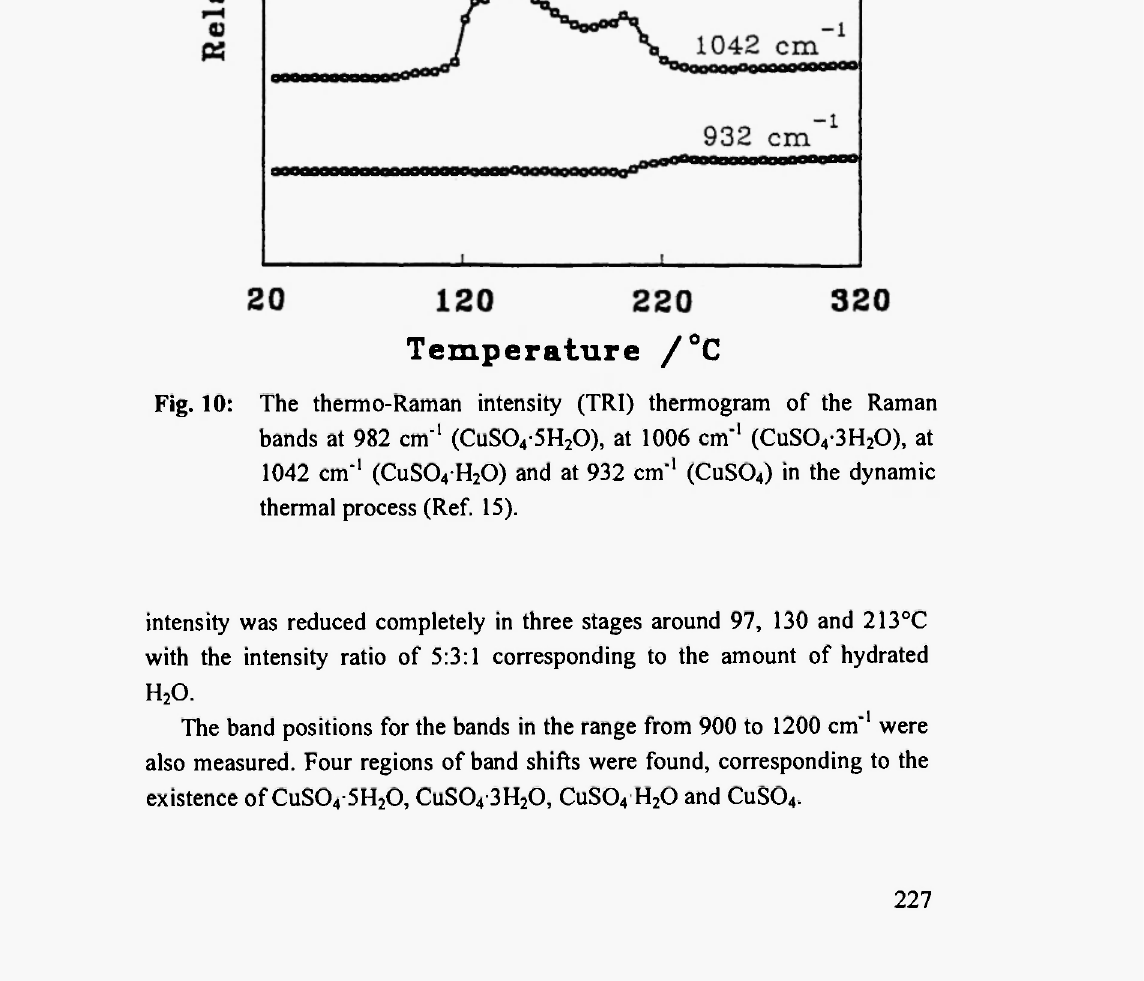
intensity was reduced completely in three stages around 97, 130 and 213°C with the intensity ratio of 5:3:1 corresponding to the amount of hydrated H O. 2 The band positions for the bands in the range from 900 to 1200 cm" 1 were also measured. Four regions of band shifts were found, corresponding to the existence of CuS0 4 -5H 2 0, CuS0 4 3H 2 0, CuS0 4 H 2 0 and CuS0 4 .